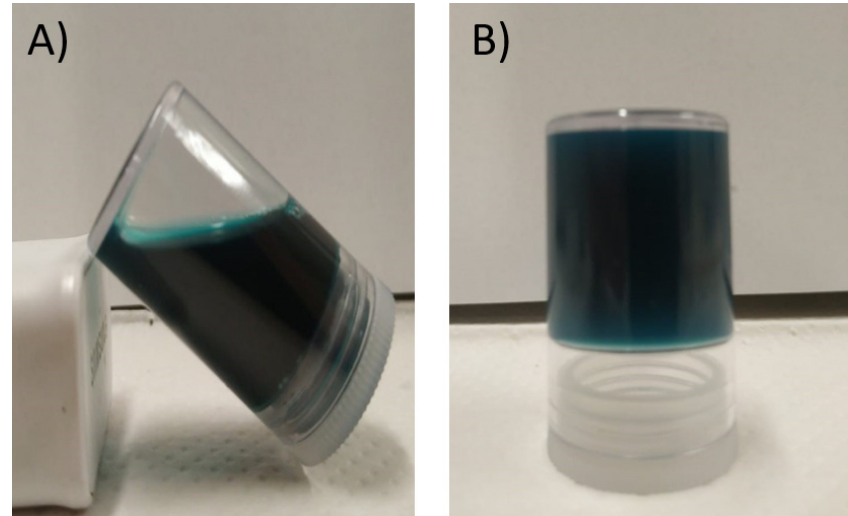
Figure 1. Digital images of the 1-GE/TN-GO-MB mixture at 50 °C performed by mixing GE (3.0 mL at 4.0% wt/vol) and TN-GO-MB (3.00 mL) ( A ). The obtained 3-GE/TN-GO-MB hydrogel created at 4 °C after the cooling process ( B ).